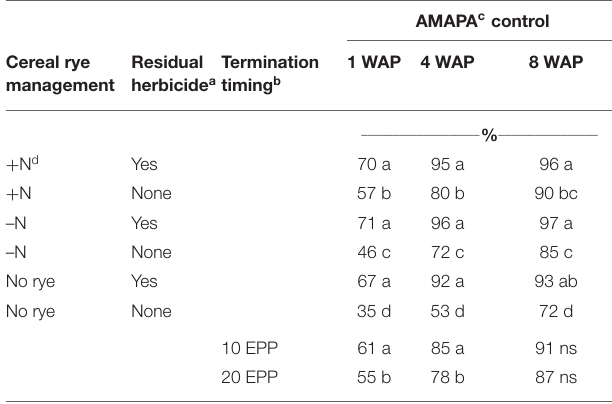
TABLE 4 | Influence of cereal rye management, termination, timing, and residual herbicides on Palmer amaranth